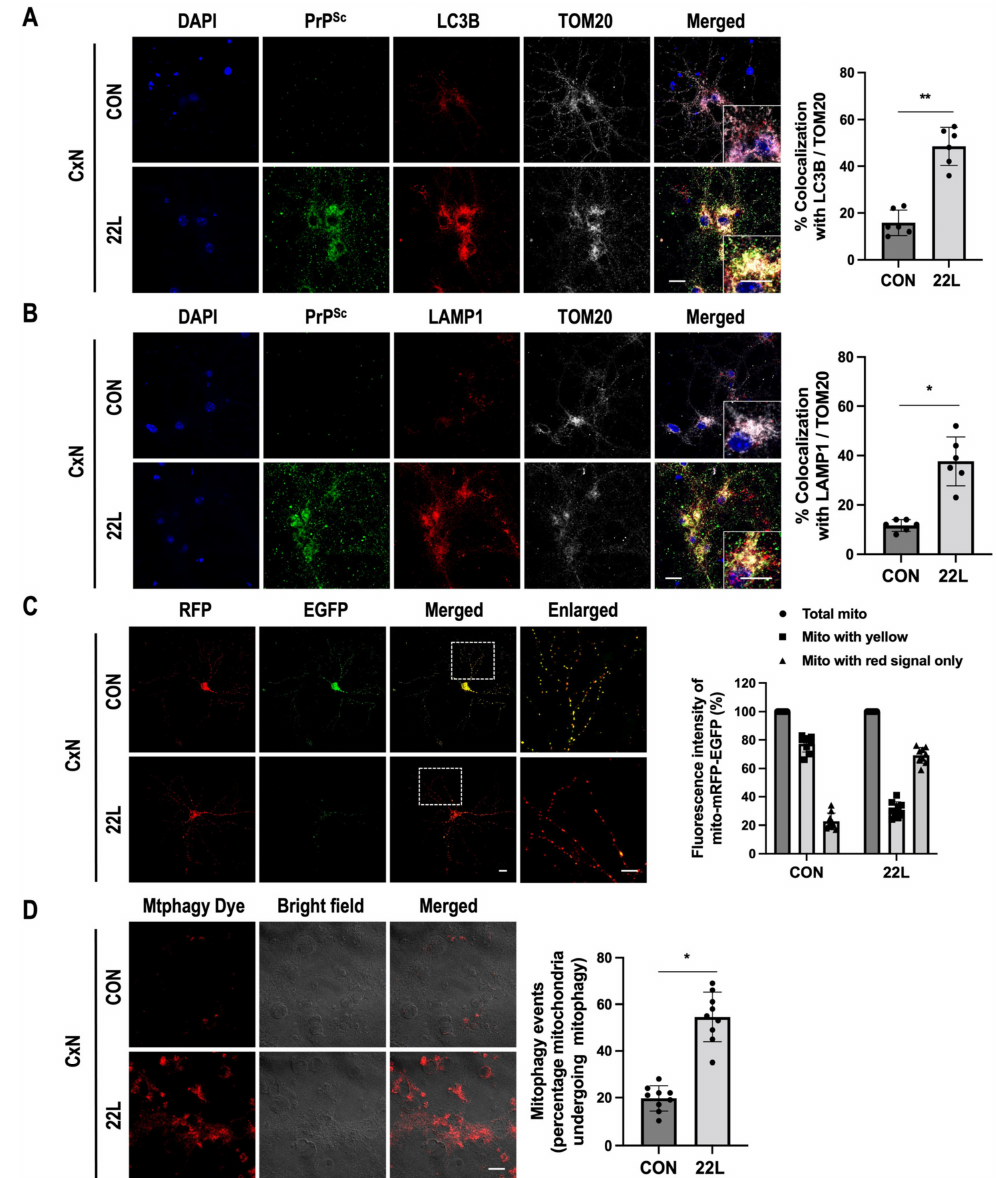
Figure 3. Scrapie infection induces autophagy in mitochondria containing PrP Sc . ( A , B ) The colocal- ization of TOM20 (white) with LC3B (red) and LAMP1 (red) in control (CON) or 22L scrapie-infected (22L) CxN cells at 21 dpi was determined using confocal microscopy. Quantification of mitophago- some ( A ) and mitophagolysosome ( B ) formation was analyzed with EzColocalization plugin for ImageJ software version 1.53a ( n = 6, ** p < 0.01, * p < 0.05; two-sided Student’s t -test). Enlarged insets (white line boxes) showed the sections at a higher magnification. For PrP Sc staining, CxN cells were treated with 98% formic acid for 7 min and then immunostained with an anti-PrP (C-20) antibody (green). ( C ) Transient expression of p-mito-RFP-EGFP by primary cortical neuronal cells targeting mitochondria was determined using confocal microscopy, and mitophagic flux was analyzed with ImageJ software version1.53a (yellow signal, no mitophagy; red signal, mitophagy). DAPI (blue) was used to counterstain the nuclei; enlarged insets (dashed white line boxes) showed the sections at a higher magnification, scale bar, 20 µ m. ( D ) Detection of mitophagy with Mtphagy Dye staining (red) using confocal microscopy in control (CON) or 22L scrapie infected (22L) CxN cells at 21 dpi. The intensities of the Mtphagy dye fluorescence were analyzed using ImageJ software and quantified for each group ( n = 9, * p < 0.05; two-sided Student’s t -test), n = number of independent experiments, scale bar, 20 µ